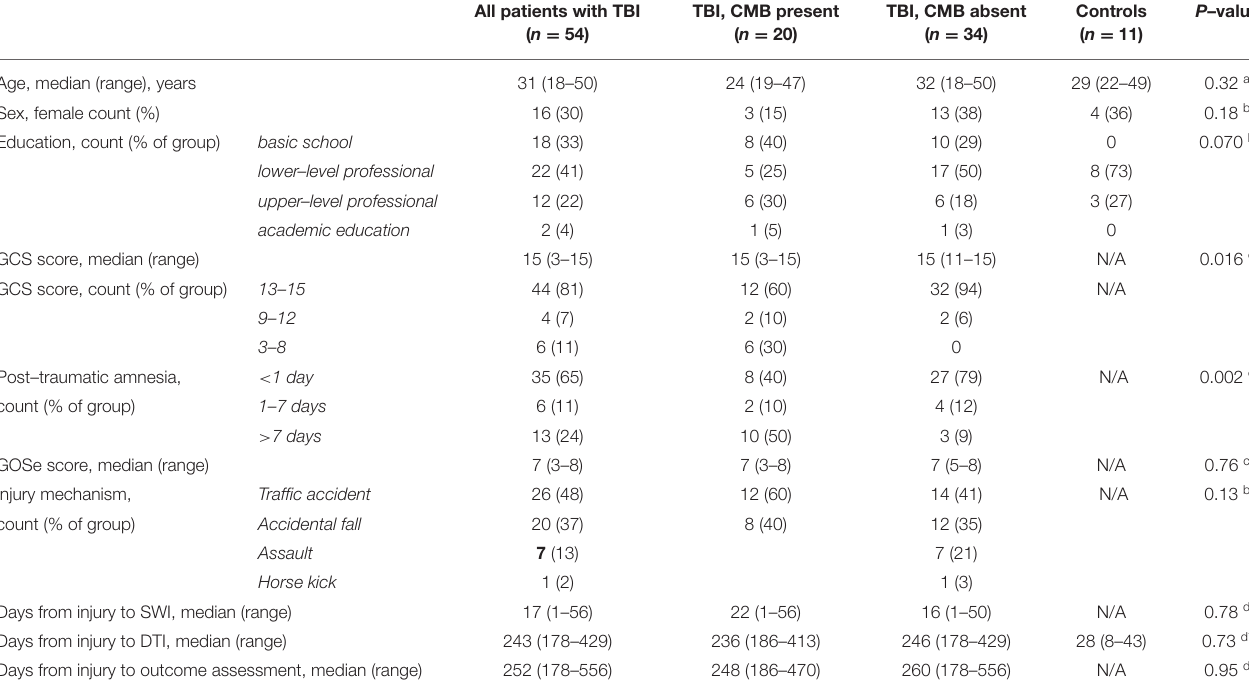
TABLE 1 | Demographics and characteristics of the patients.